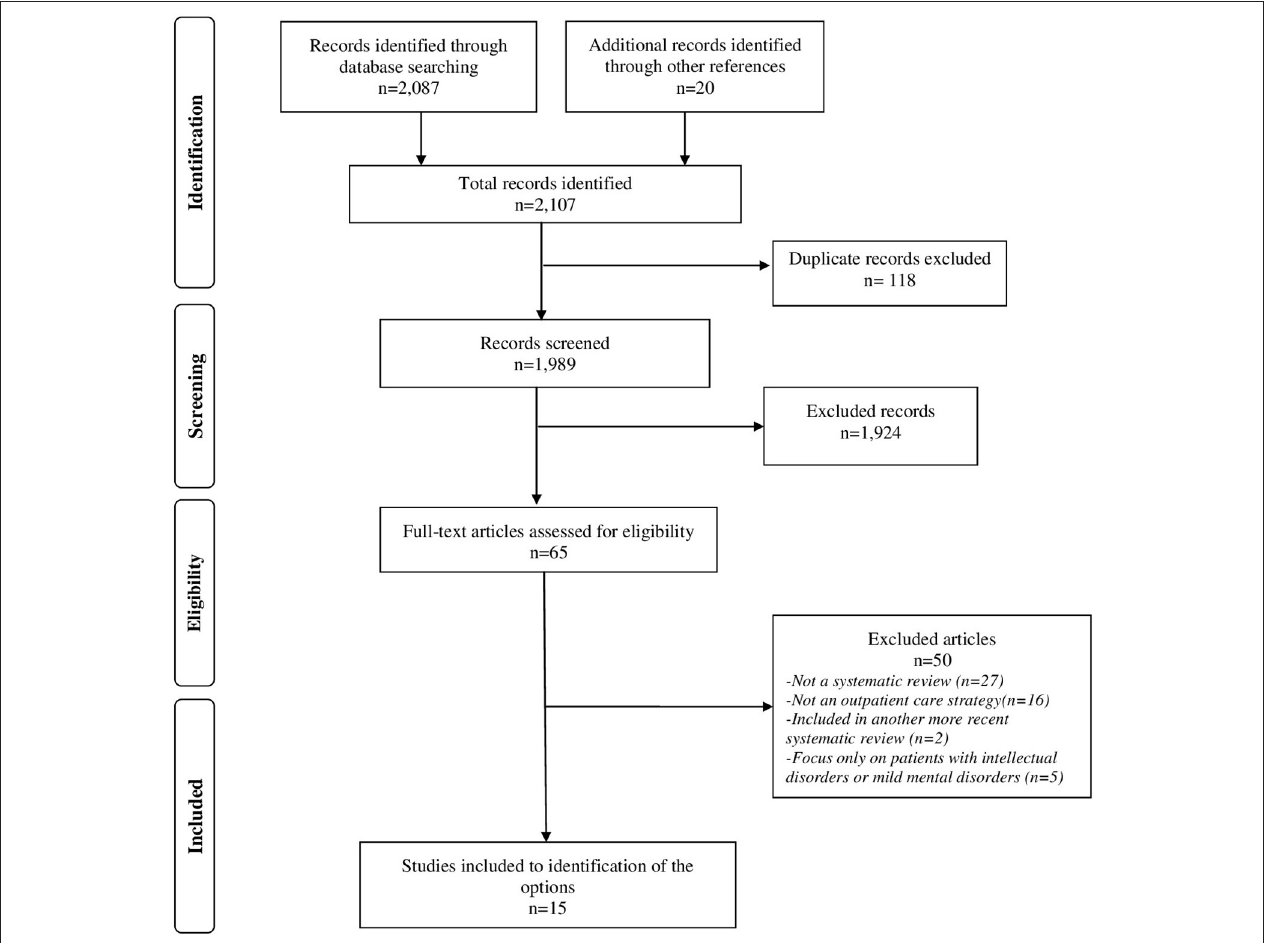
FIGURE 2 | Flow diagram for study